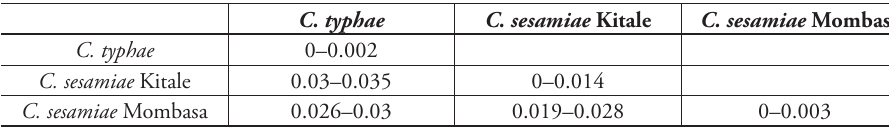
Table 4. Minimum and maximum divergence of COI sequences between C. typhae and two populations of C. sesamiae .